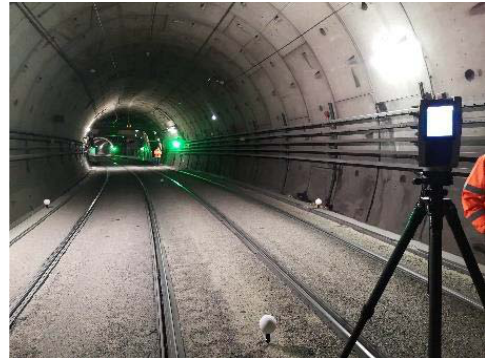
Figure 1: TLS data acquisition in low lightning